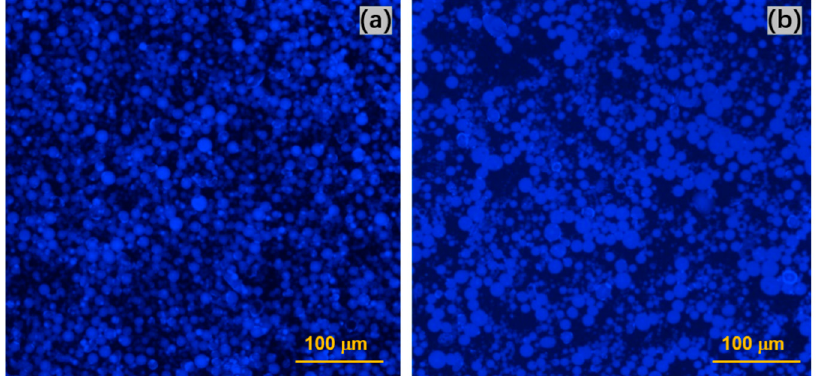
Figure 6. Fluorescence images of CNF2.5%-DDAB0.1% ( a ) before and ( b ) after deformation at a wavelength of 460 nm that was captured by the constant shear from 0.1 s − 1 to 1000 s − 1 .